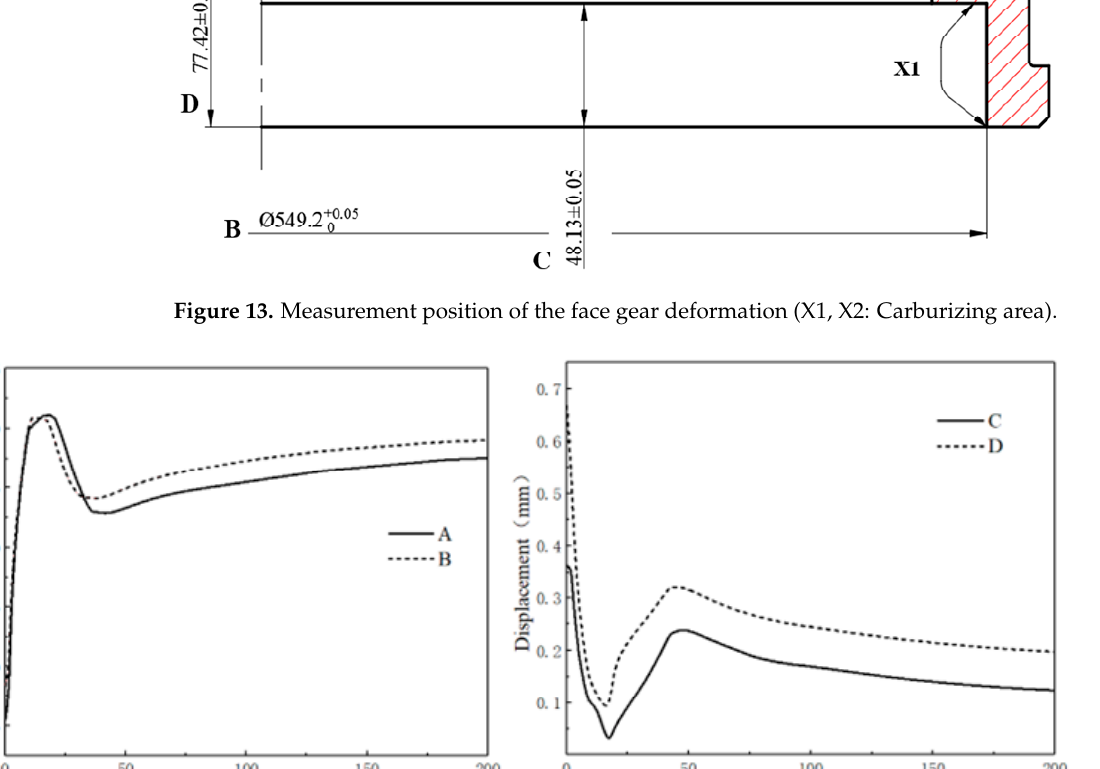
Figure 14. Axial and radial deformation of the gear during quenching for 200 s.